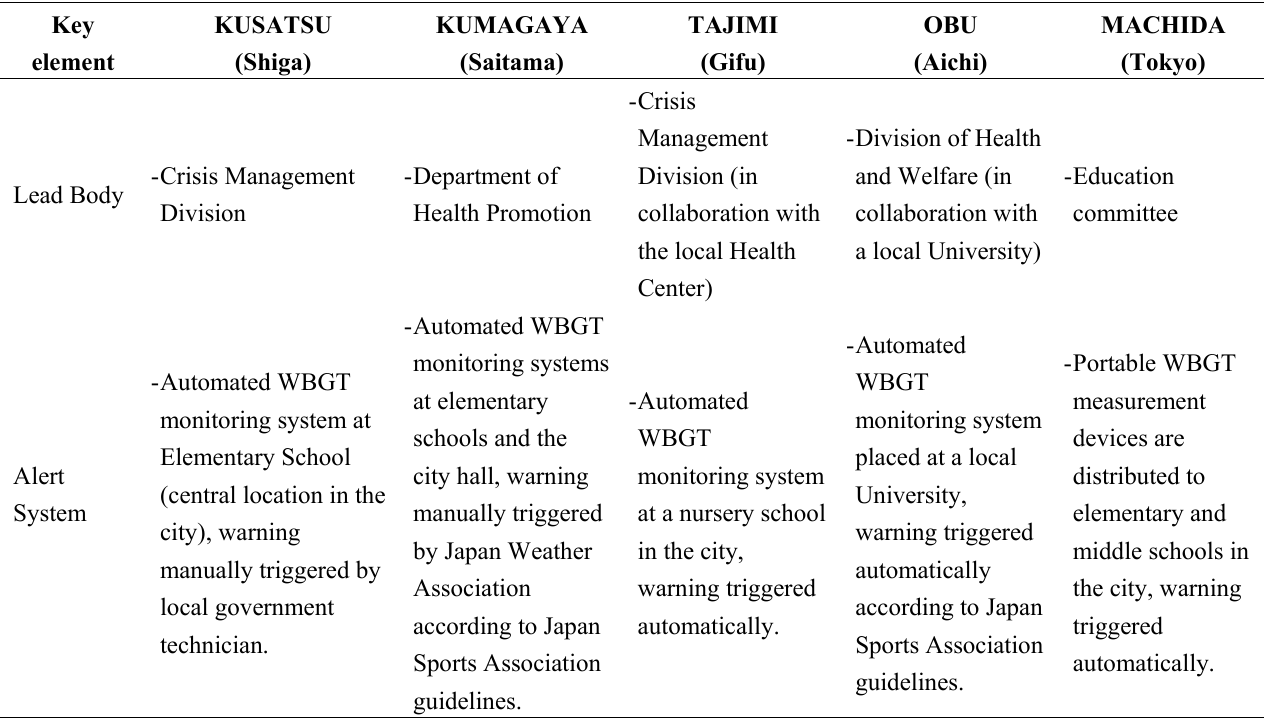
Table 1. Key elements of locally operated heat stroke prevention plans in